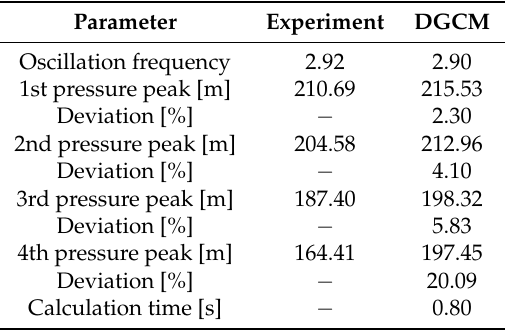
Figure 10. Comparison of the experimental data of experiment 6 [43] with the simulated results obtained with DGCM. Table 7. Comparison of DGCM and experimental results for experiment 6